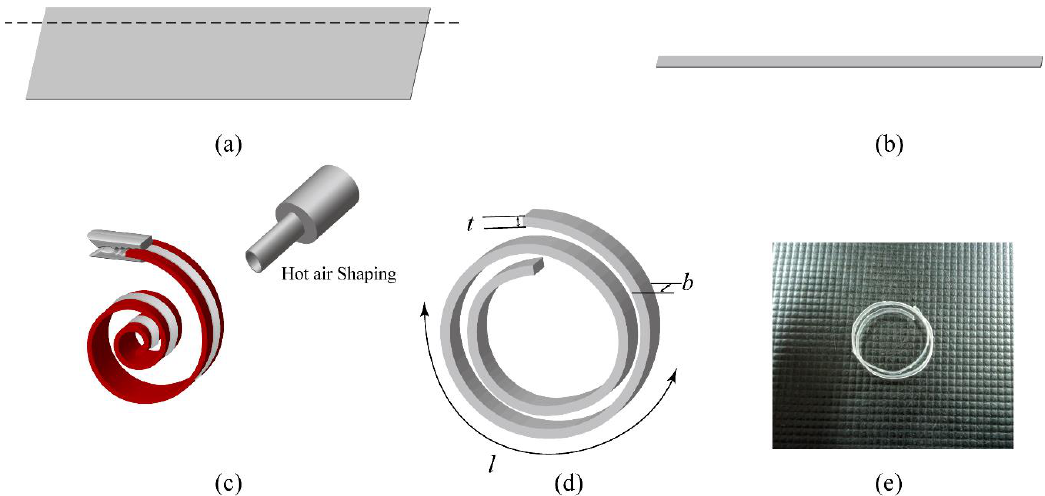
Figure 7. The fabrication of the spiral spring. ( a ) A thin film of PET with the thickness of 25 μm was prepared. ( b ) A thin strip was cut from the film and clamped on an acrylonitrile butadiene styrene